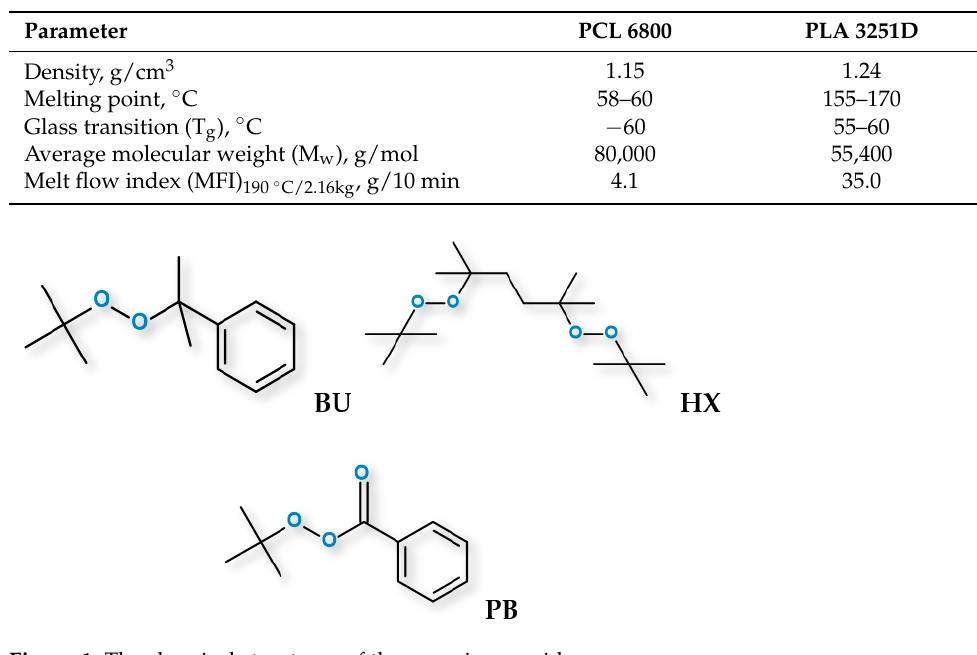
Figure 1. The chemical structures of the organic peroxides. Table 1. The characteristics of the used materials.